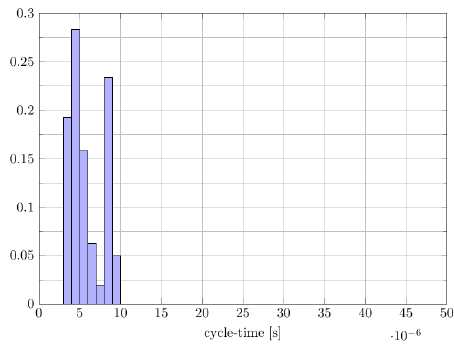
Figure 7. Relative frequency of cycle times of the equilibrium and shape system over 10,000 cycles. WCET is 10 µ